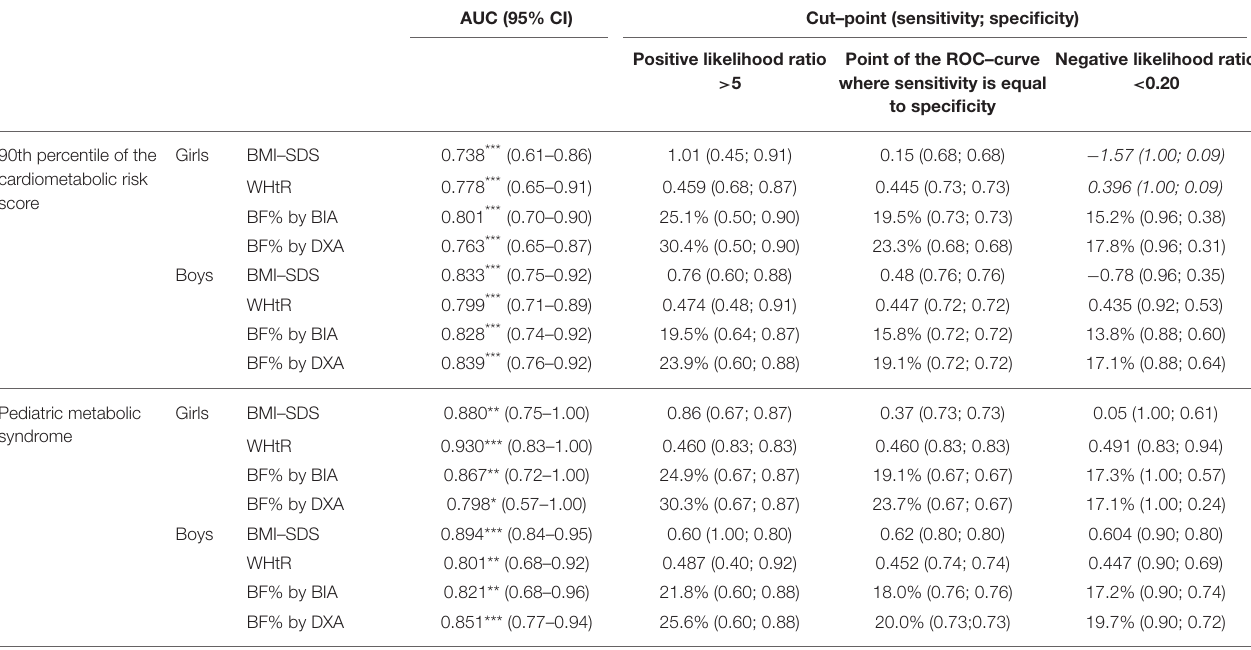
TABLE 3 | Receiver operating characteristics and adiposity criteria for measures of adiposity among girls and boys by 90th percentile of the cardiometabolic risk score and by pediatric metabolic syndrome.